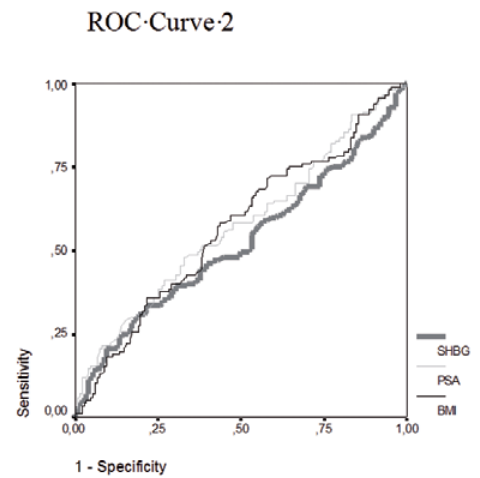
Figure 1 - Receiver operating characteristic analysis curve comparing SHBG serum levels and BMI in patients with and without prostate cancer (ROC Curve 1) and in patients with low vs high grade disease (ROC Curve